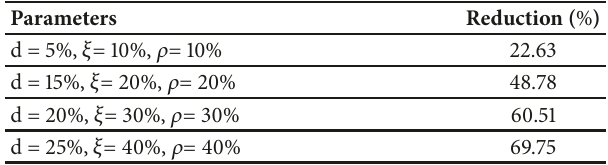
Table 6: Percentage reductions for each parameter